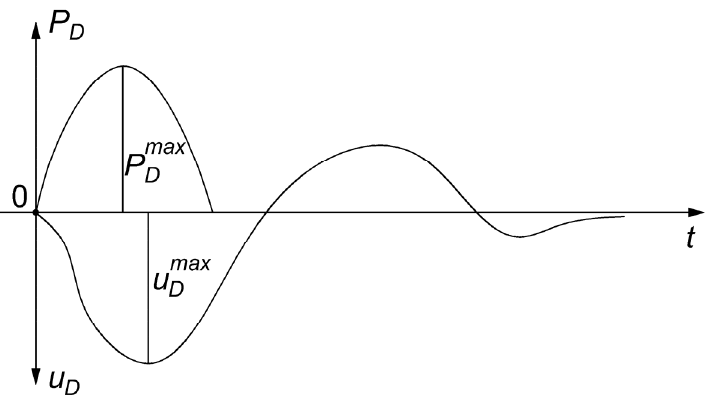
Figure 6. Variability in time t of loading force P D and displacement u D in a dynamic test [30].